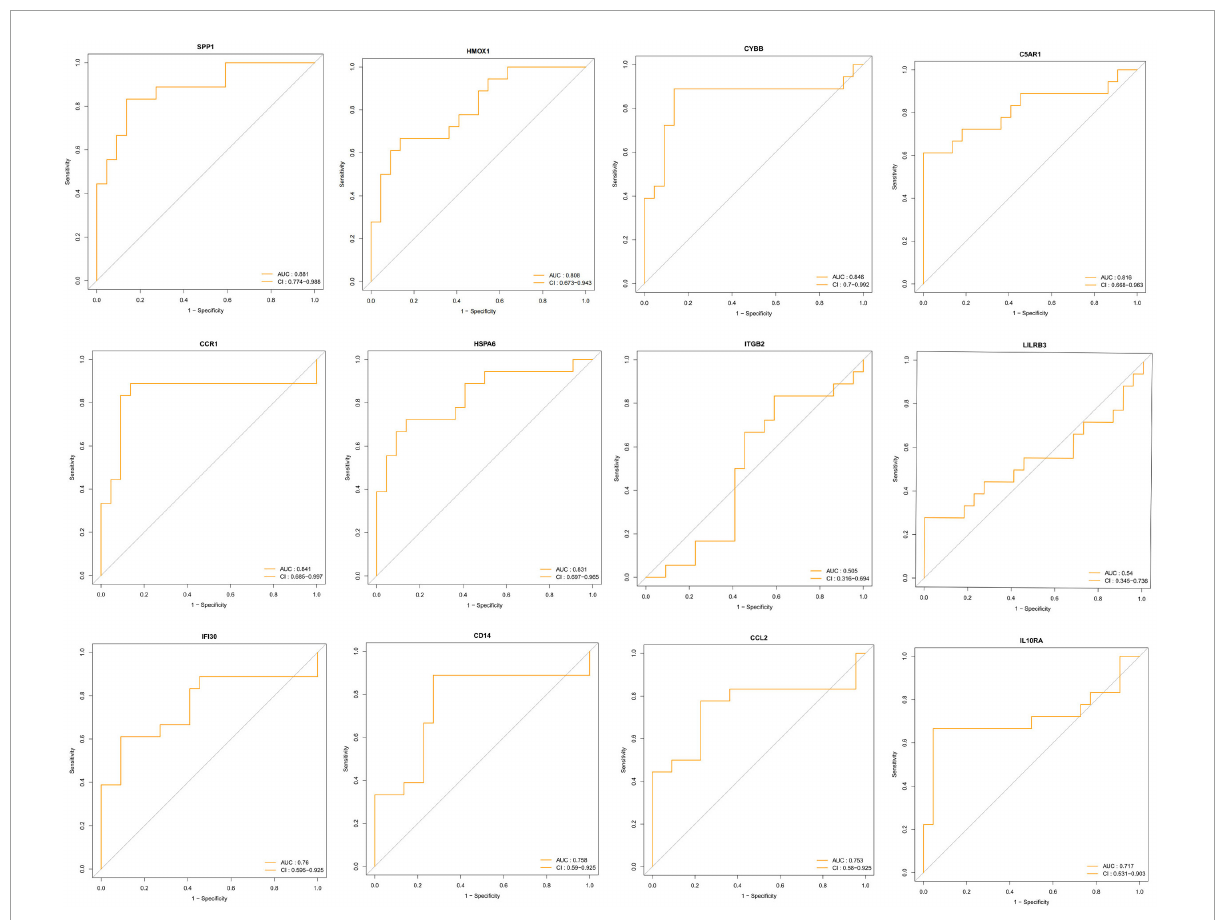
FIGURE8 Receiver operating characteristic (ROC) analysis of differentially expressed immune-related genes in the vascular dementia